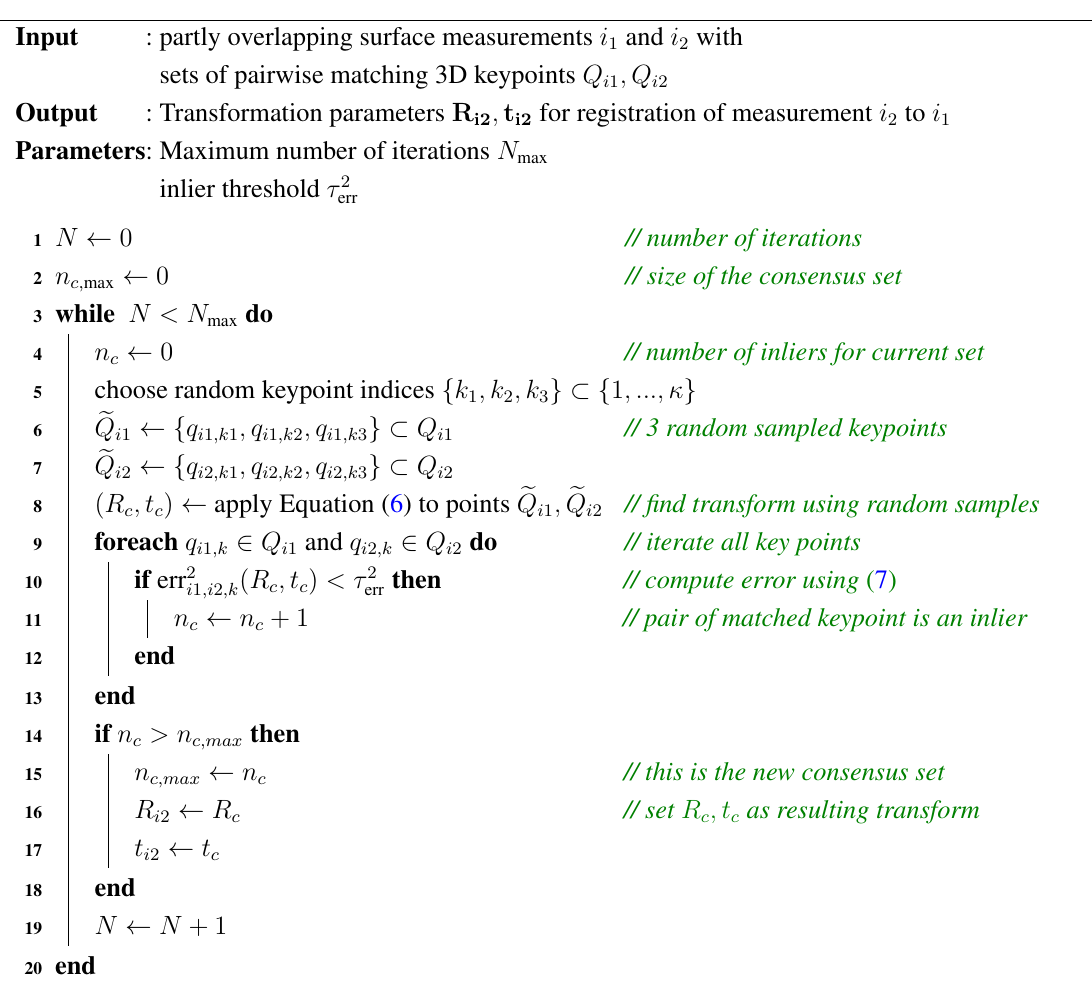
Figure 7. Pseudo-Code of the RANSAC algorithm Figure 8. Pseudo-Code of the RANSAC